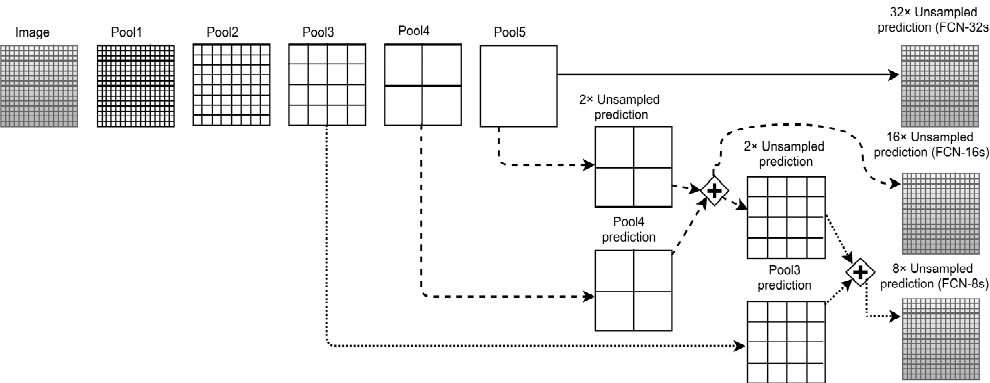
Figure 2 . Visualization of the VGG-FCN architecture. The figure depicts the skip connection architecture that was devised in [29]. Only the pooling and prediction layers are shown, omitting the intermediate convolutional layer. The image shows the FCN-32s variant (without skip connections) on top, the FCN-16s variant in the middle and FCN-8s variant at the bottom.